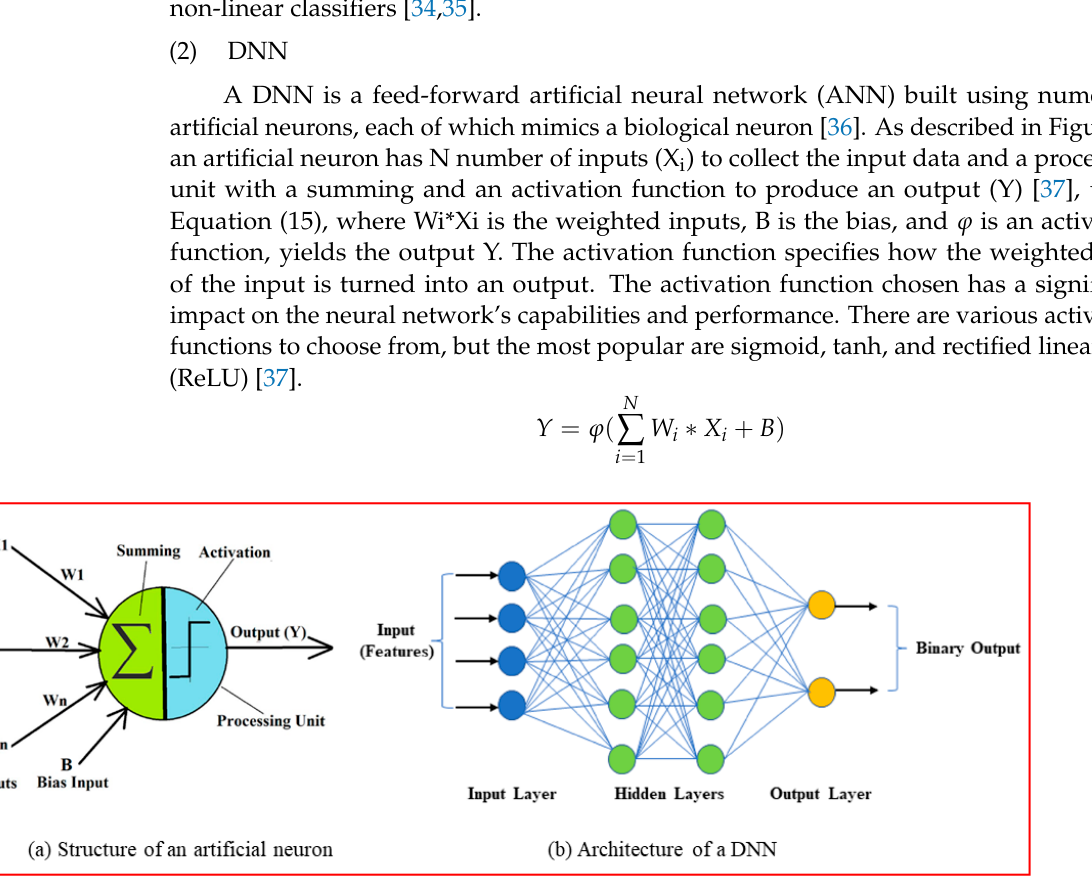
Figure 8. Structure of artificial neuron network [37].